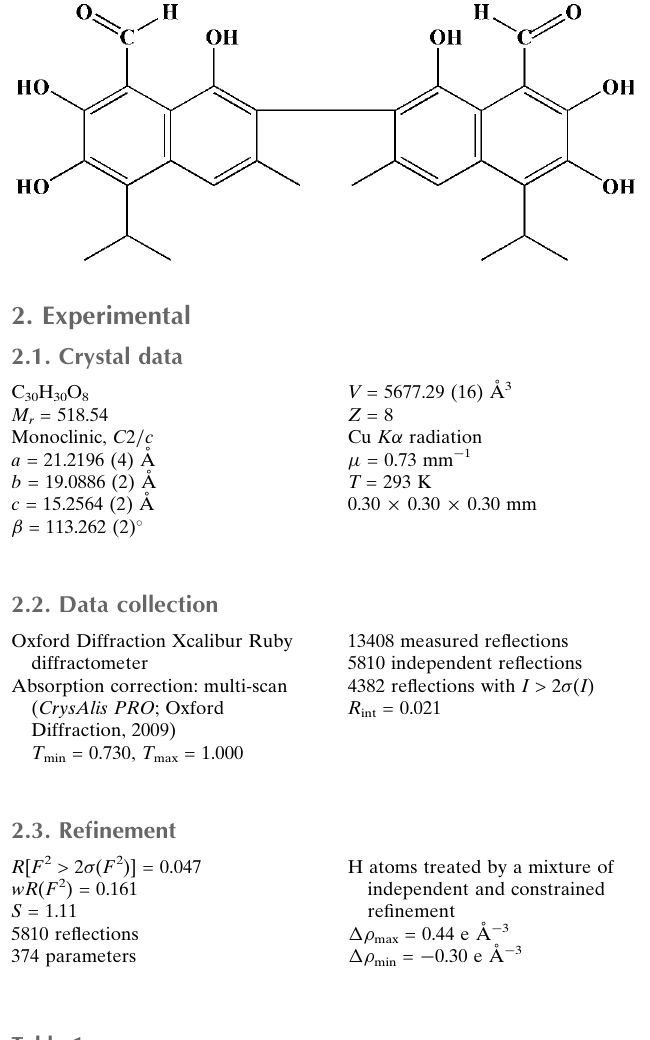
Hydrogen-bond geometry (A˚ , (cid:2)